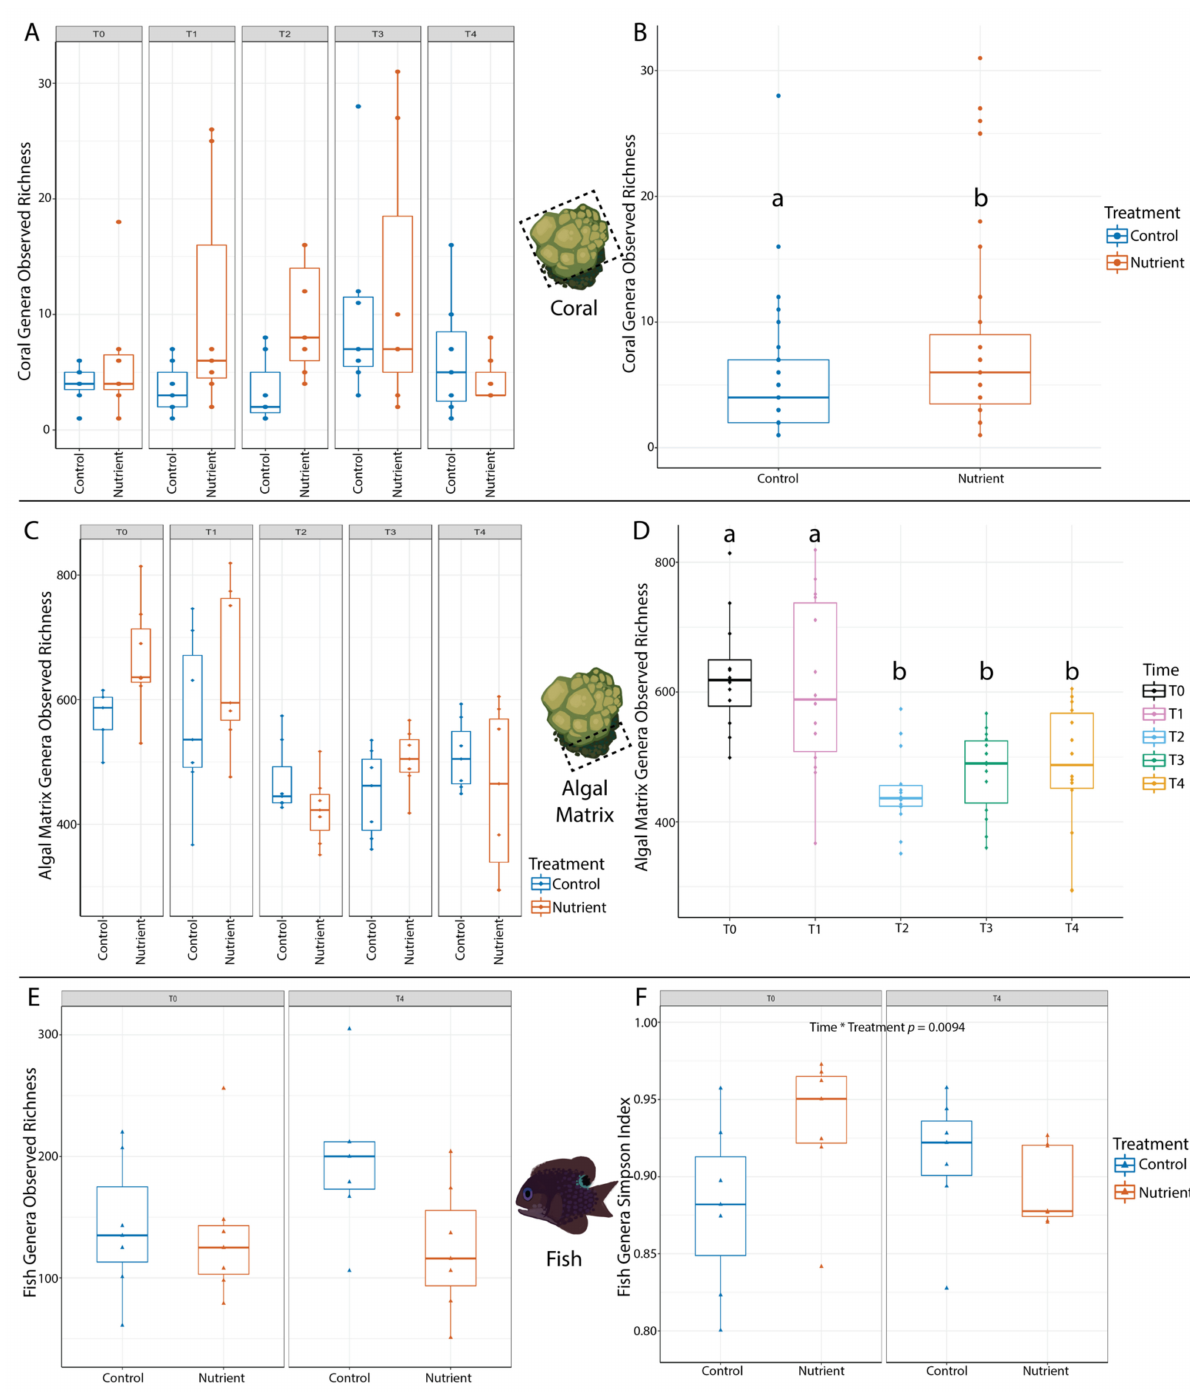
Figure 2. Alpha diversity results for coral, fish, and algal matrix microbiomes. Only statistically significant results are shown in graphs on the right ( B , D , F ). ( A ) Coral microbiome observed richness increases for nutrient treated colonies over time (T0–T2), and then becomes more similar between treatments from timepoint T3–T4. ( B ) Only treatment had a significant effect on coral microbiome observed richness, with increased diversity for nutrient treated colonies. ( C ) Algal matrix microbiome observed richness changed more over time than between treatments. ( D ) Only time had a significant effect on algal matrix observed richness, with diversity decreasing over time. ( E ) Fish microbiome observed richness increased over time for control colonies and remained similar for nutrient treated colonies. ( F ) Only the Time*Treatment interaction had a significant effect on fish microbiome Simpson diversity. Lower-case letters indicate statistical significance, i.e. boxes that do not have any letters in common are significantly different from one another ( B , D